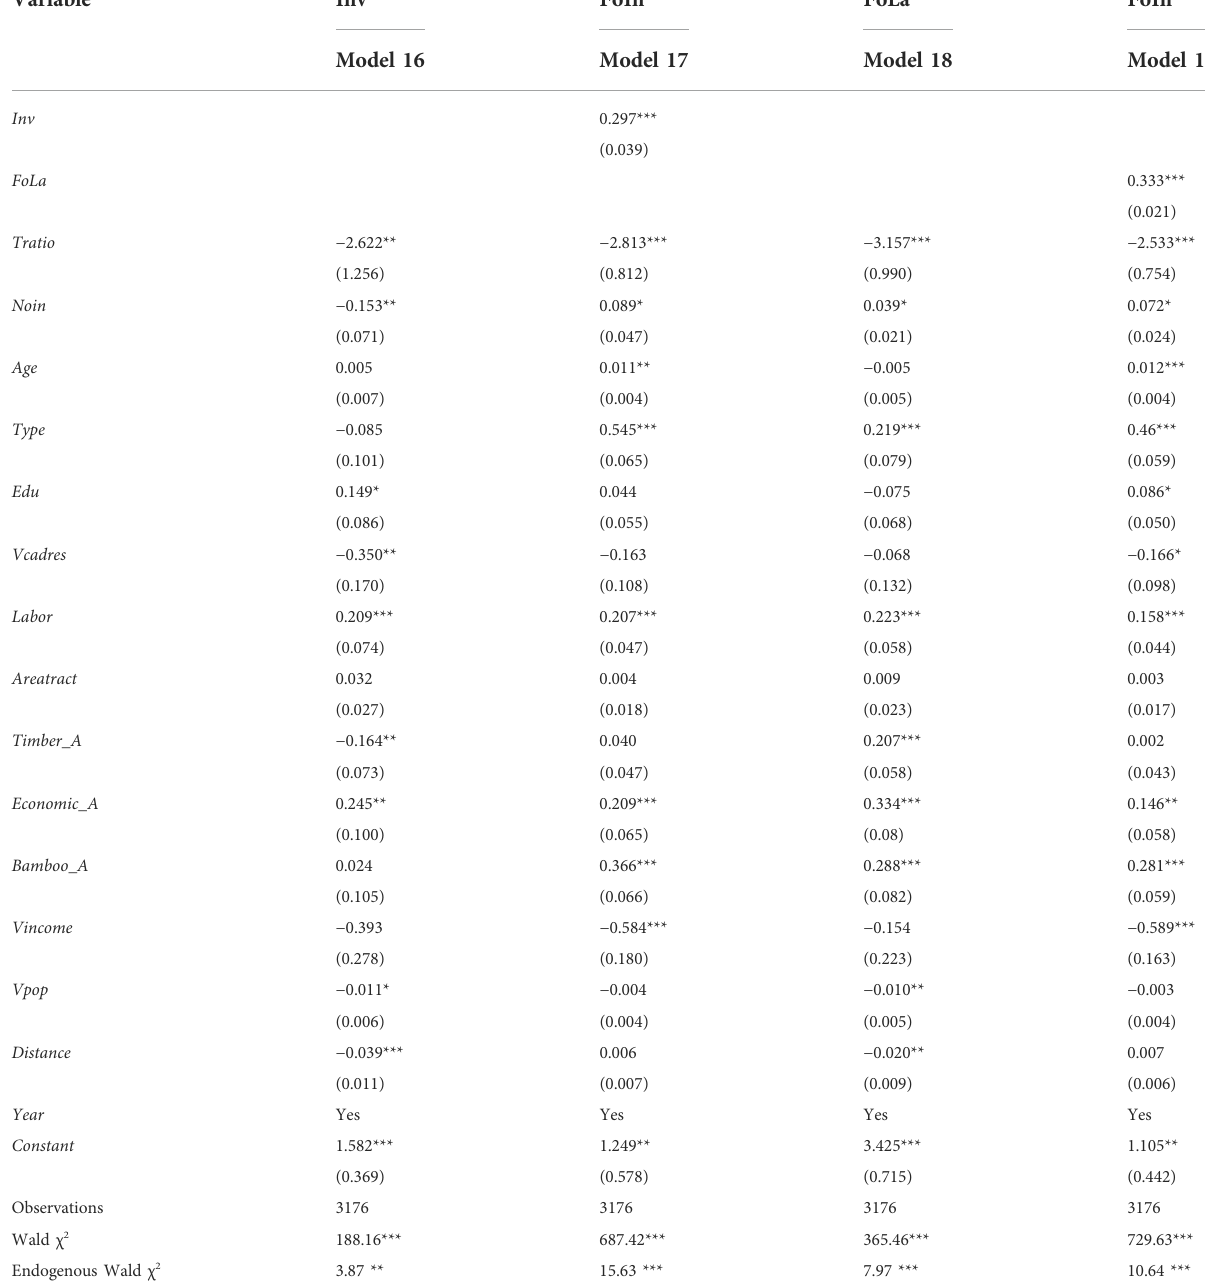
TABLE 5 Mechanism of the effect of labor migration on the forest management income.